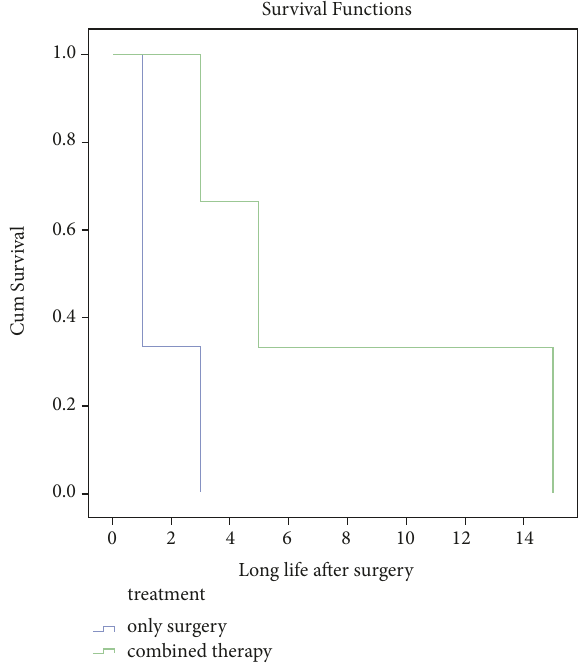
Table 1: Clinical-pathological characteristics of adenocarcinoma.